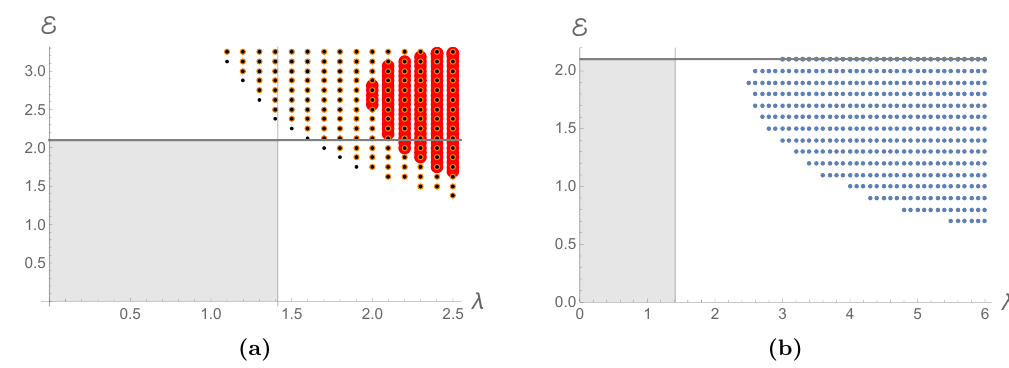
Figure 22. Stable orbits of pointlike charged particles for (a) the black hole for T = 0 : 517254 (red), T = 1 : 91981 (orange), and T = 9 : 55129 (gray) and (b) the soliton. A stable pair of particles that decrease the free energy of the black hole solution would fall in the gray